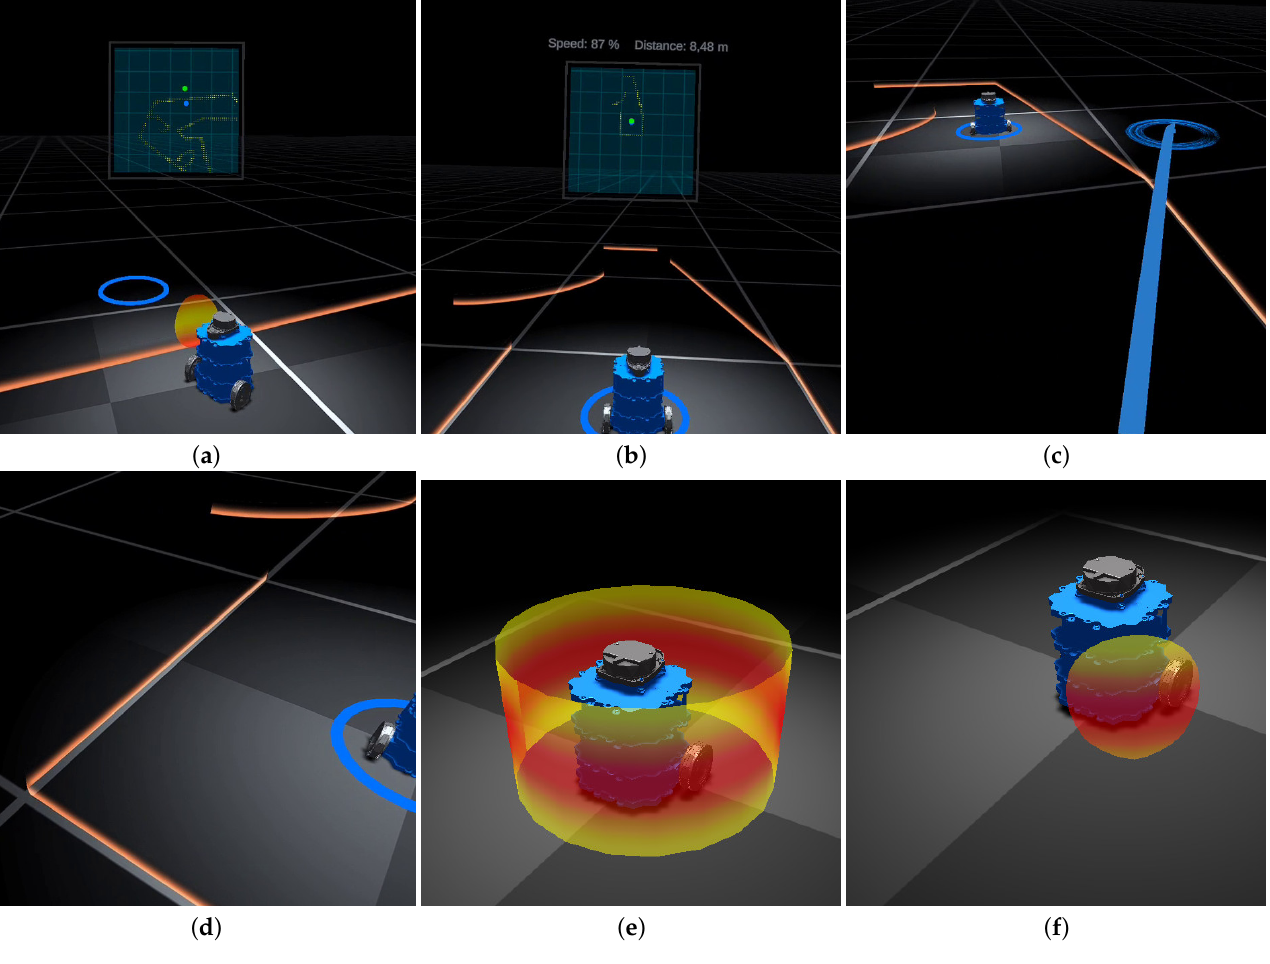
Figure 2. VE overview. ( a ) The 2D map view and 3D view. ( b ) Requested information data. ( c ) Tele- porting (blue arrowed circle). ( d ) Detected objects (elements in brown). ( e ) Mobile robot boundary (full view). ( f ) Mobile robot boundary (local view). 2D map: robot (blue circumference in ( a )); reference (green circumference in ( a )); detected objects (yellow points in ( a , b )). 3D environment: reference (blue circle in ( a )); system information (i.e., robot velocity and distance to the target) in ( b ); teleporting (blue arrowed circle in ( c )); detected objects (brown walls in all figures); mobile robot boundary as a circle (2D) or cylinder (3D) (red–yellow elements in ( e , f